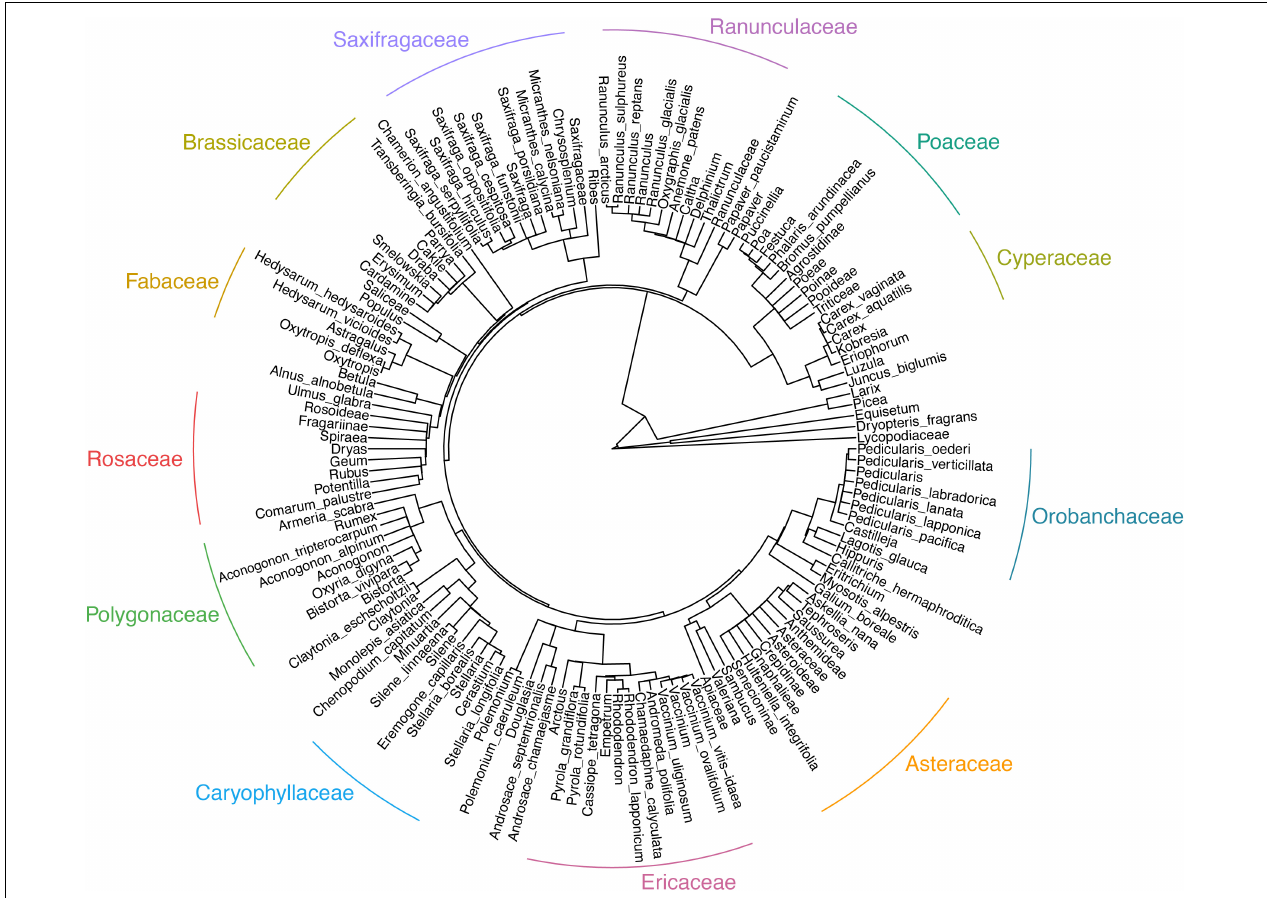
FIGURE 5 | Phylogenetic tree of plant taxa from sedimentary ancient DNA, demonstrating the evolutionary relationship of the presented plant taxa from subarctic Far East Russia covering the last 28 thousand years. TABLE 1 | Pearson’s correlation between plant assemblage composition and taxonomic and phylogenetic diversity in the records inferred from sedimentary ancient DNA (sedaDNA) from subarctic Far East Russia. 28–0 ka 28–14 ka 14–0